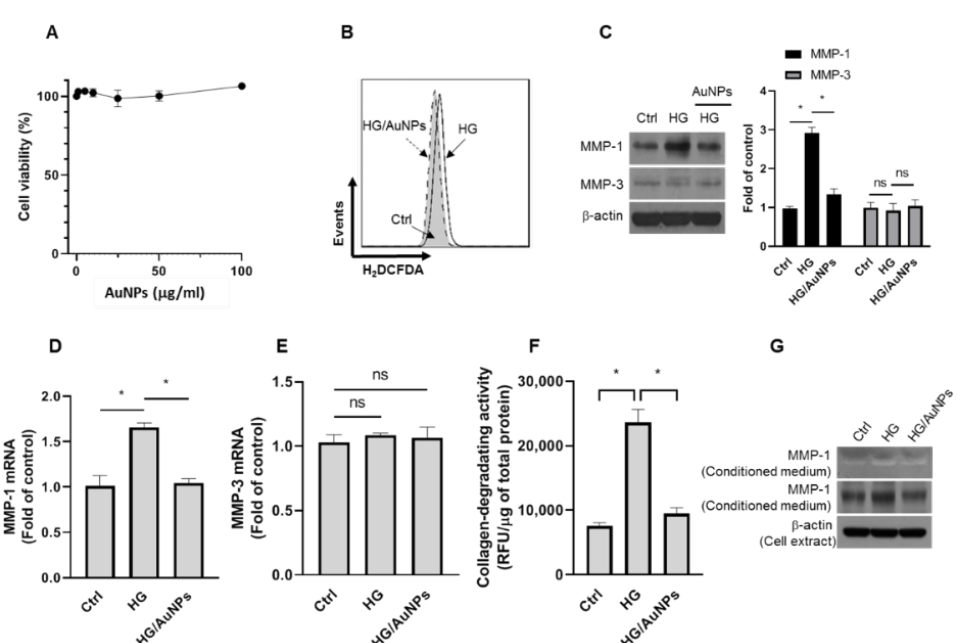
Figure 3. Effect of GA–AuNPs on MMP-1 expression in high glucose-treated CCD-966SK cells. ( A ) Effect of GA–AuNPs on the viability of cells. CCD-966SK cells were treated with GA–AuNPs (0, 1, 5, 10, 25, 50, or 100 µ g/mL) for 24 h. The results were expressed as the percentage of cell viability relative to the control. ( B – G ) CCD-966SK cells were pretreated with 10 µ g/mL GA–AuNPs for 1 h, and then incubated with 30 mM glucose for 24 h. ( B ) Effect of GA–AuNPs on ROS generation in high glucose-treated cells. Cellular ROS content was measured by flow cytometer in an H 2 DCFDA fluorogenic probe assay. ( C ) Effect of GA–AuNPs on MMP-1 and MMP-3 protein expression in high glucose-treated cells. ( Left panel ) Western blot analyses; ( right panel ) quantification of protein ex- pression from Western blot analyses (* p < 0.05). Effect of GA–AuNPs on transcription levels of MMP-1 ( D ) and MMP-3 ( E ) mRNA in high glucose-treated cells. The MMP-1 and MMP-3 mRNA levels were analyzed by real-time RT-PCR (* p < 0.05; NS, statistically insignificant). ( F ) Effect of GA–AuNPs on collagen-degrading activity on a culture medium of high glucose-treated cells. Collagen-degrading activity was analyzed by a fluorescence microplate reader at Ex/Em = 490/520 nm (* p < 0.05; NS, statistically insignificant). ( G ) Effect of GA–AuNPs on MMP-1 in culture medium of high glucose- treated cells. Collagen zymography and Western blot detecting MMP-1 from conditioned medium. Western blot detecting β -actin from cell